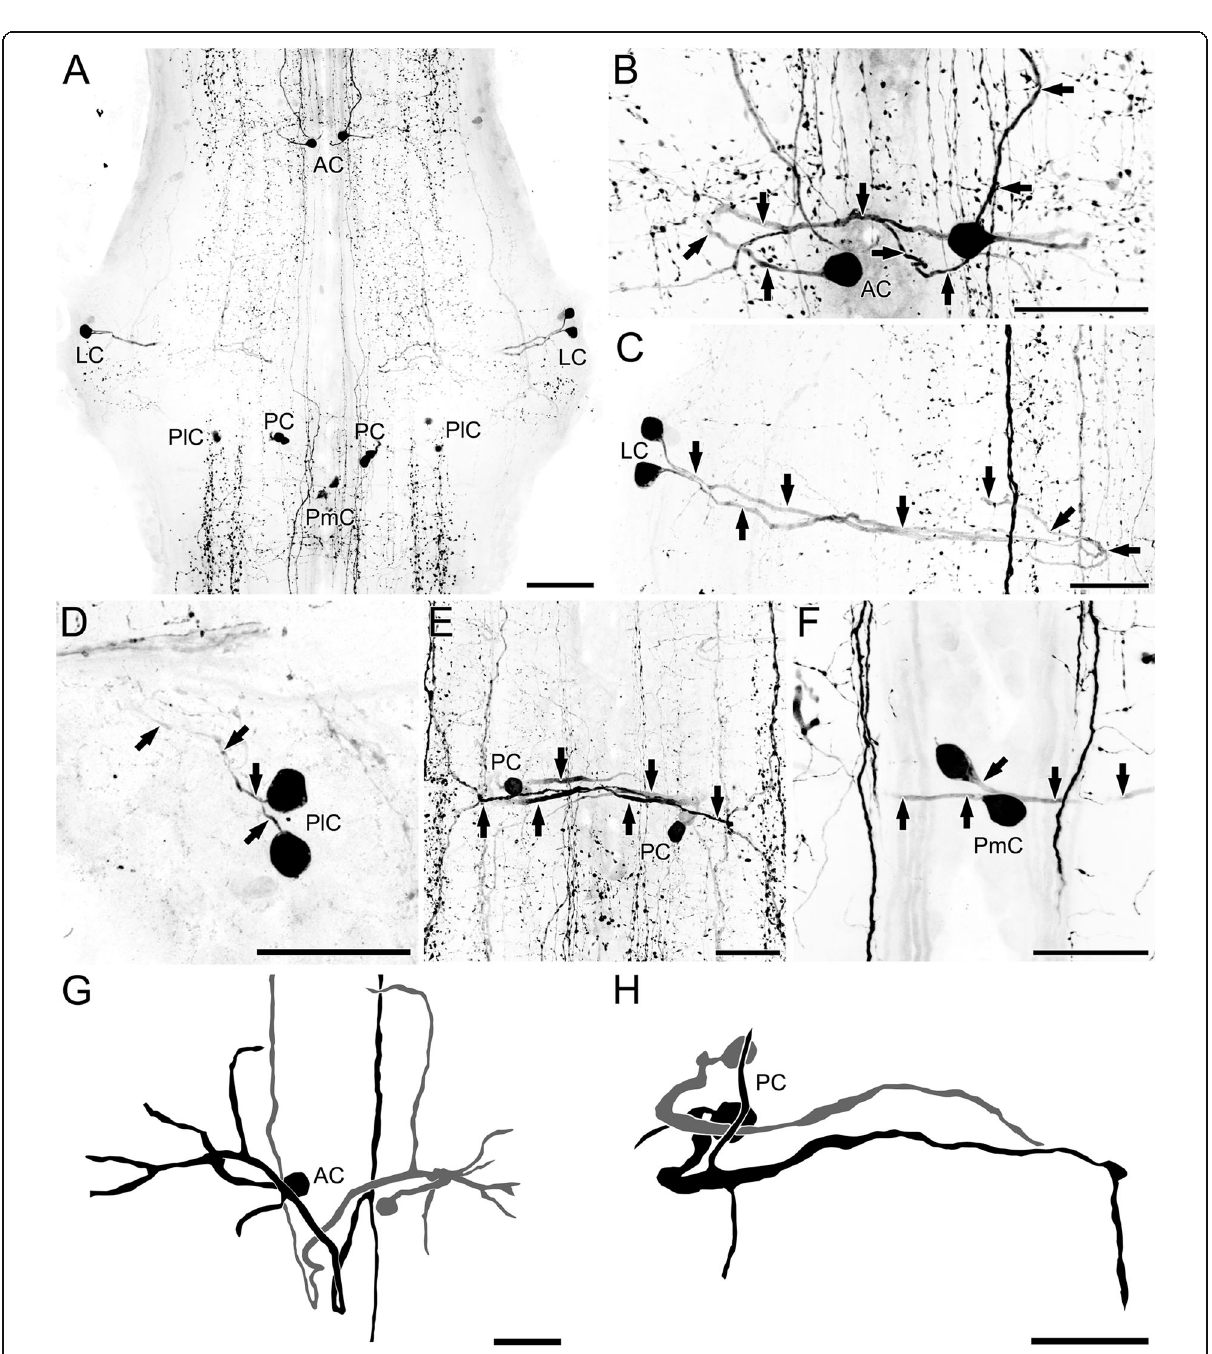
Fig. 3 Distribution of 5HT-ir neurons in the VNC of Scutigera coleoptrata . All neurons were detected in every ganglion of all preparations. a These individually identifiable neurons can be distinguished according to somata positions within the ganglia into anterior (AC), lateral (LC), postero-lateral (PlC), posterior (PC), and postero-medial cells (PmC). b The AC project their neurites contralaterally (indicated for the left neuron by arrows). c The LC project their neurites medially towards the midline, but do not cross the latter (arrows). d Neurites of the PlC could only be traced for a short distance, projecting antero-laterally (arrows). e The pair of PCs sent their processes contralaterally (arrows). f The PmCs project laterally (arrows). As these cells are situated near the midline it was not always clear whether they project ipsi- or contralaterally. g Reconstructions of ACs. h Reconstructions of PCs. Compare also Fig. 6. Scale bars: A = 100 μ m; B – H = 50 μ